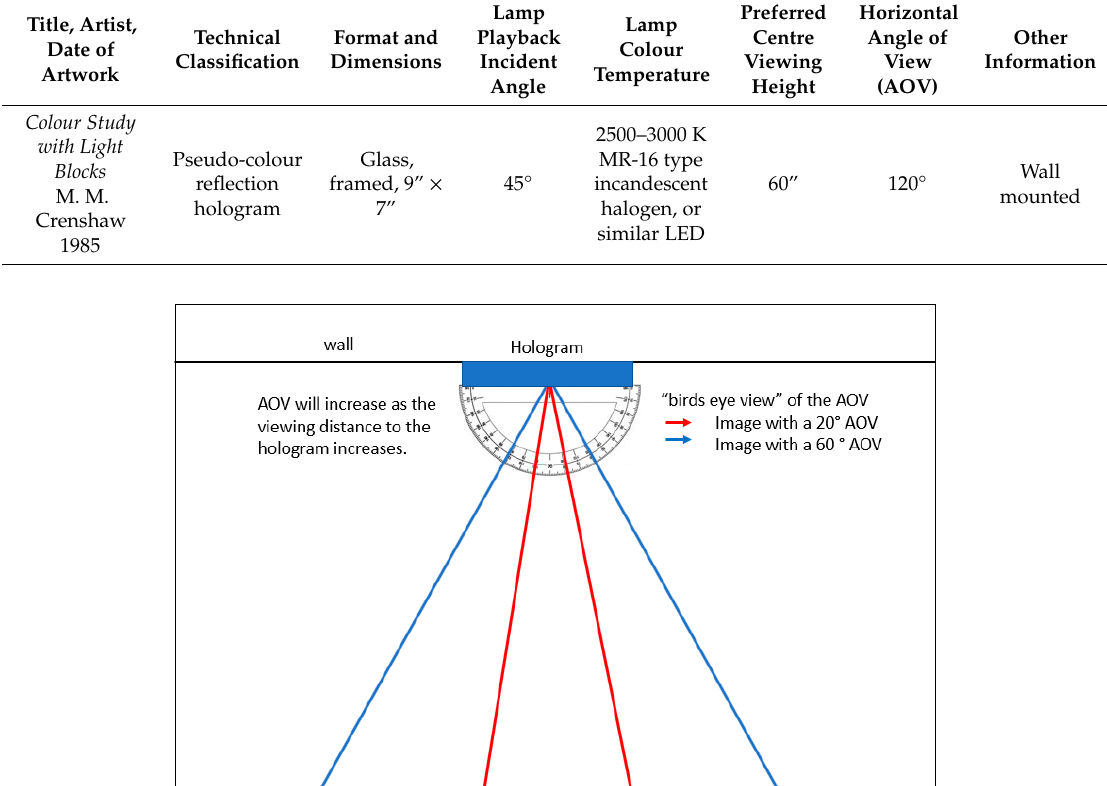
Figure 12. Birds eye view diagram of the angle of view of a hologram with a 20° AOV, and one with a 60° AOV.